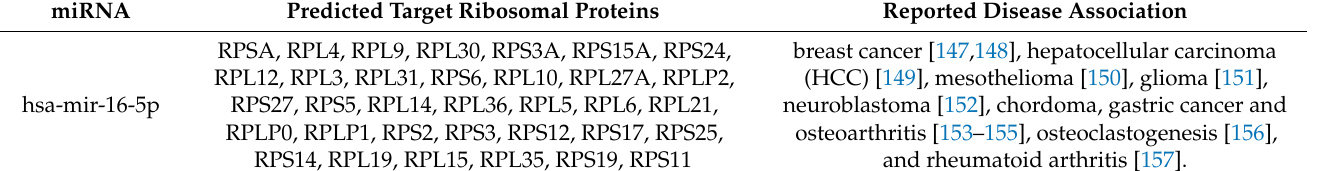
Table 4. The top 14 miRNAs that are predicted to target most of the ribosomal proteins (RPs), along with their reported association to the